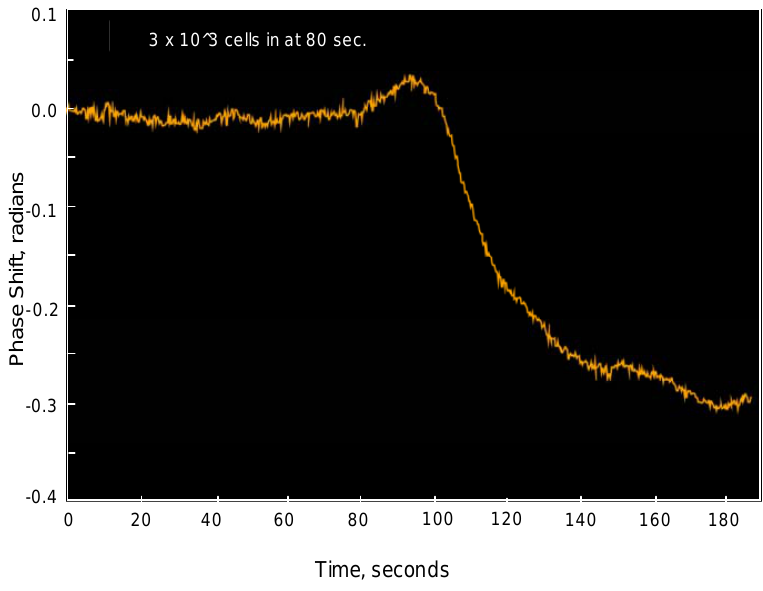
Figure 8. Interferometer Response with exposure to water solutions containing E. coli O1:H57 at 3 × 10 3 cells/mL.